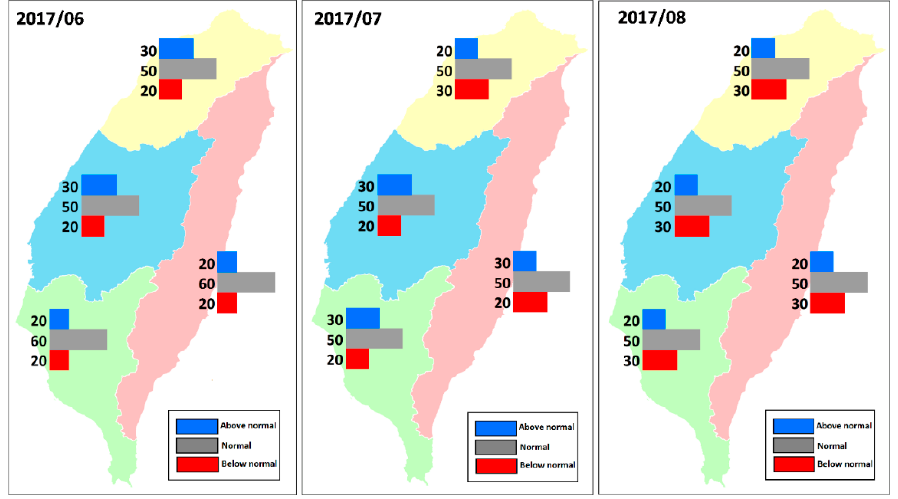
Figure 2. Illustration of seasonal forecasts by the CWB.